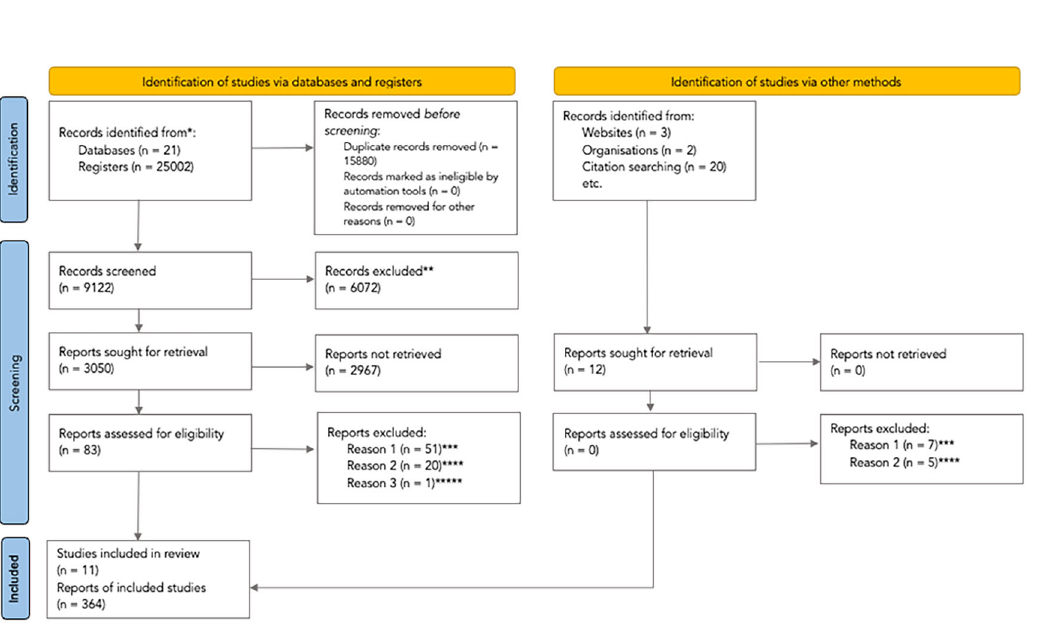
Figure 1. PRISMA flowchart of the studies selection process (PRISMA ; Page et al. , 2021). * The appendix 1 shows the number of records identified from each database or register searched. ** All records were excluded by